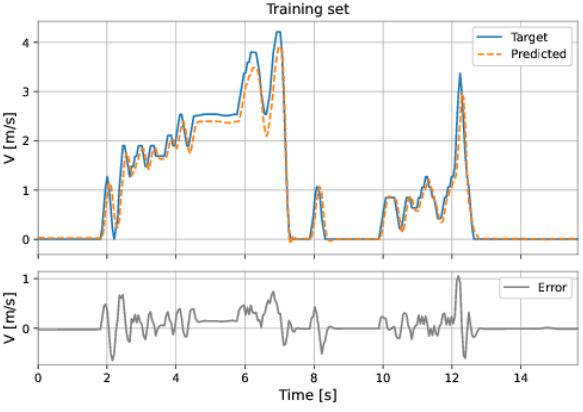
Figure 55. LSTM-NARX results (series-parallel). Training set.